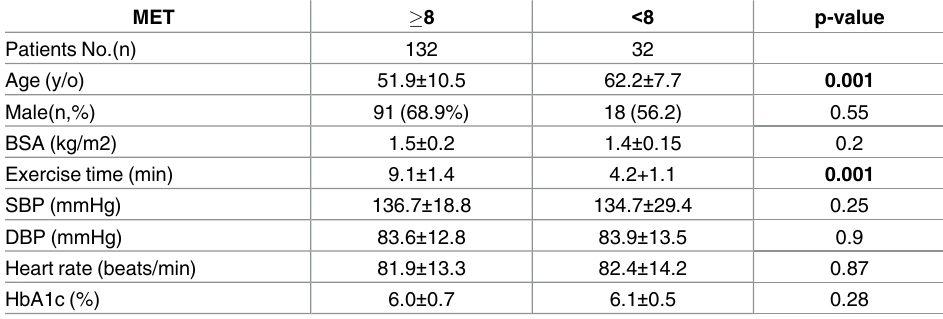
Table 1. Comparison of clinical characteristics between subjects with preserved(MET (cid:21) 8) and impaired functional capacity (MET < 8). MET (cid:21) 8 < 8 p-value Patients No.(n) 132 32 Age (y/o) Male(n,%) Exercise time (min) SBP (mmHg) DBP (mmHg) Heart rate (beats/min) HbA1c (%) Data are expressed as mean ± SD. BSA = body surface area; SBP = systolic blood pressure; DBP = diastolic blood